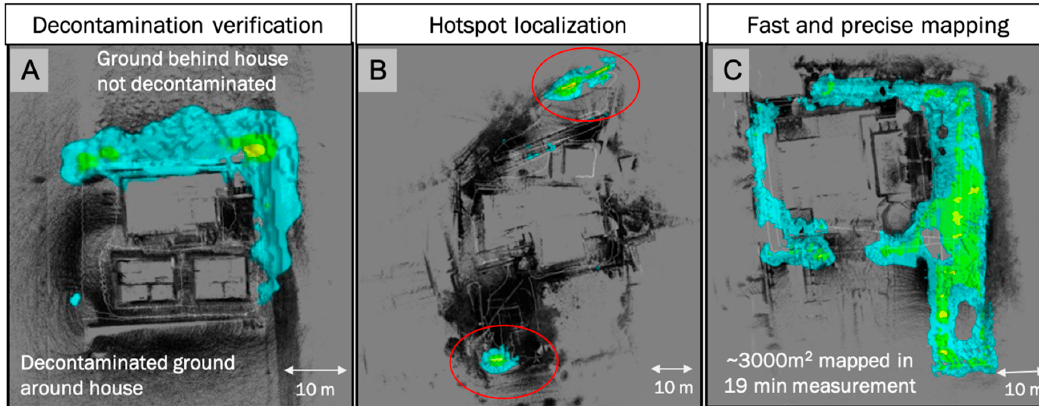
Figure 3. Top-down views of 3-D point clouds (black) and radiation maps (color) in evacuated urban areas in the Fukushima Prefecture. All measurements were performed with the portable gamma-ray imager HEMI in combination with a LiDAR sensor. The measurement times in these areas were always less than 20 min. ( A ) Buildings with decontaminated (1–4 µ Sv / hr) and not-decontaminated areas ( < 0.4 µ Sv / hr); ( B ) Building complex and parking lots with hot spots of about 10 µ Sv / hr; ( C ) Contaminated areas around building complex 1–4 µ Sv / hr).